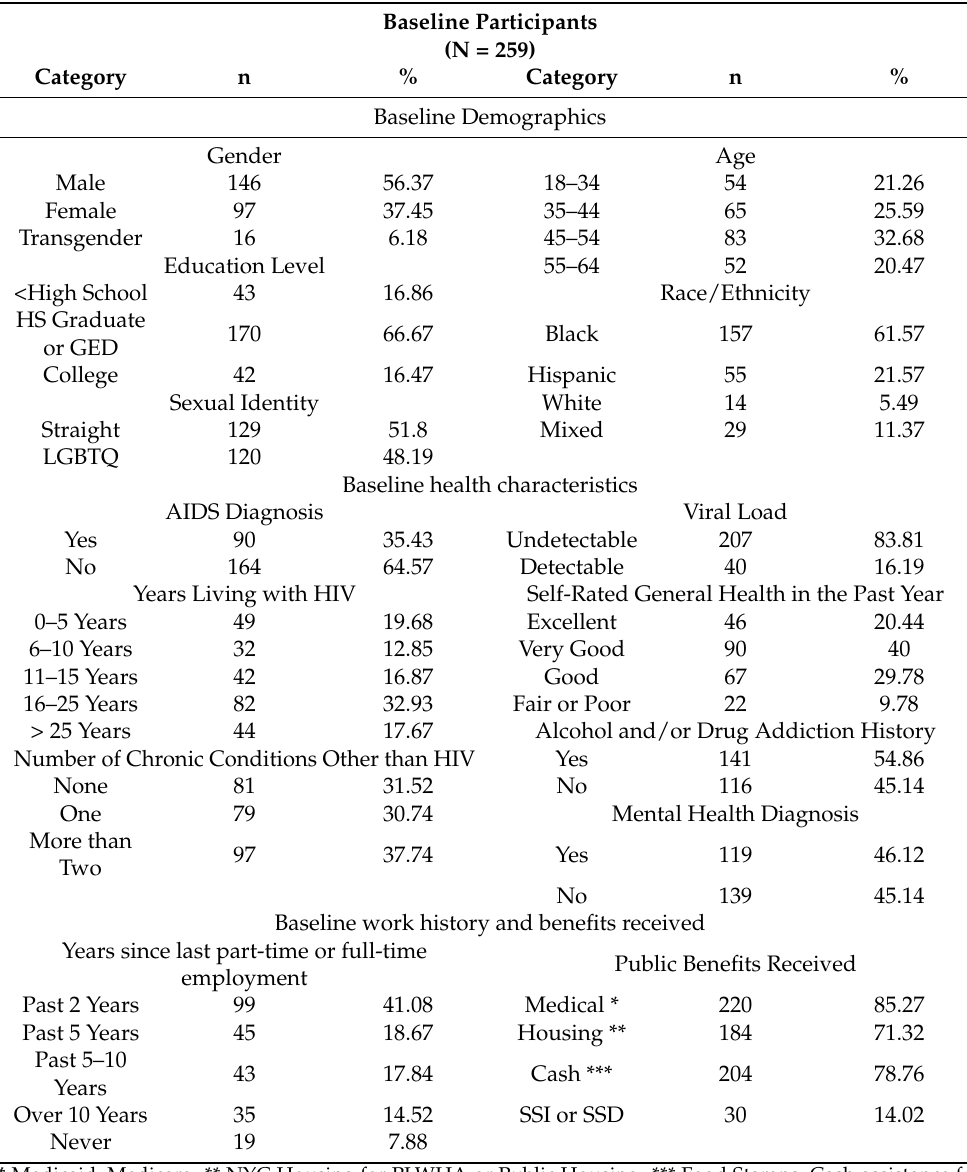
Table 3. Baseline sociodemographic characteristics of